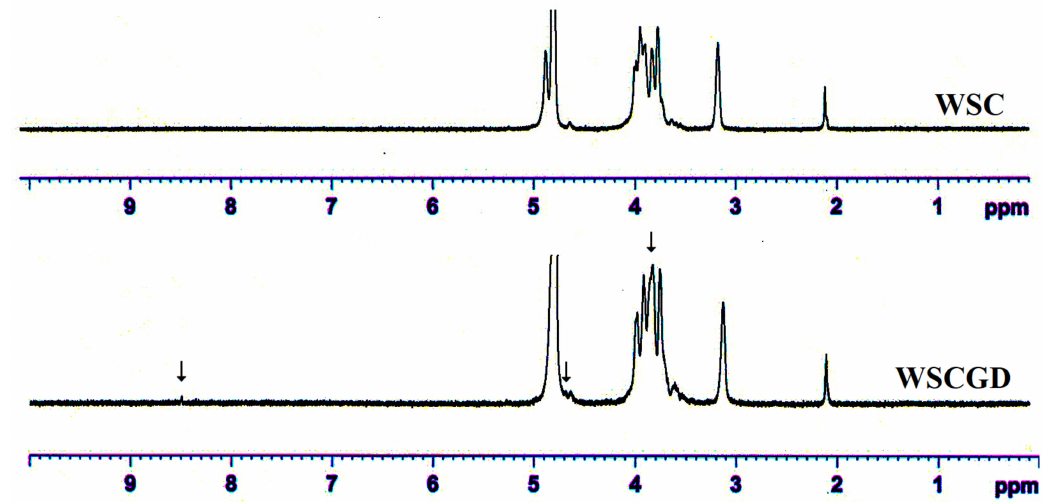
Figure 5. Typical 1 H-NMR profiles of WSC and WSCGD. ↓ indicating the di ff erence in 1 H-NMR signal of WSCGD comparing to that of WSC.